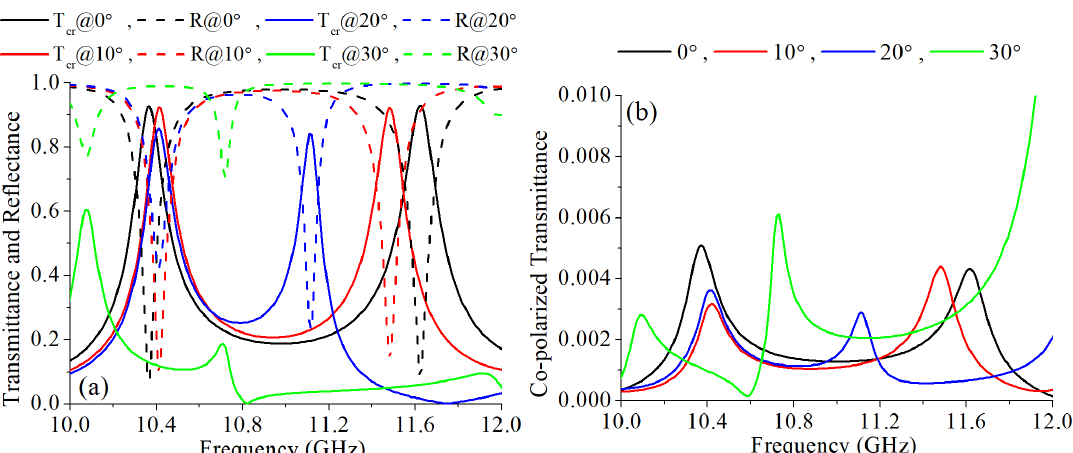
Figure 8. Simulation results with different incident angles: ( a ) The simulated cross-polarized transmittance and reflectance. ( b ) The simulated co-polarized transmittance.